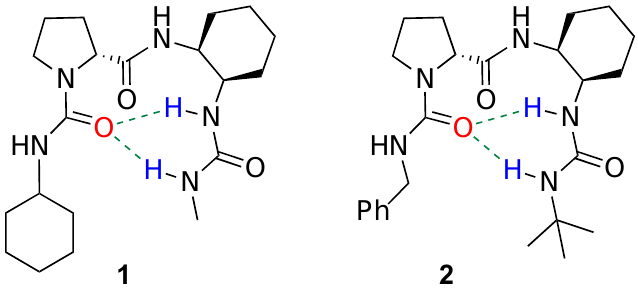
Figure 1. β -turn-inducing structures containing two urea fragments.